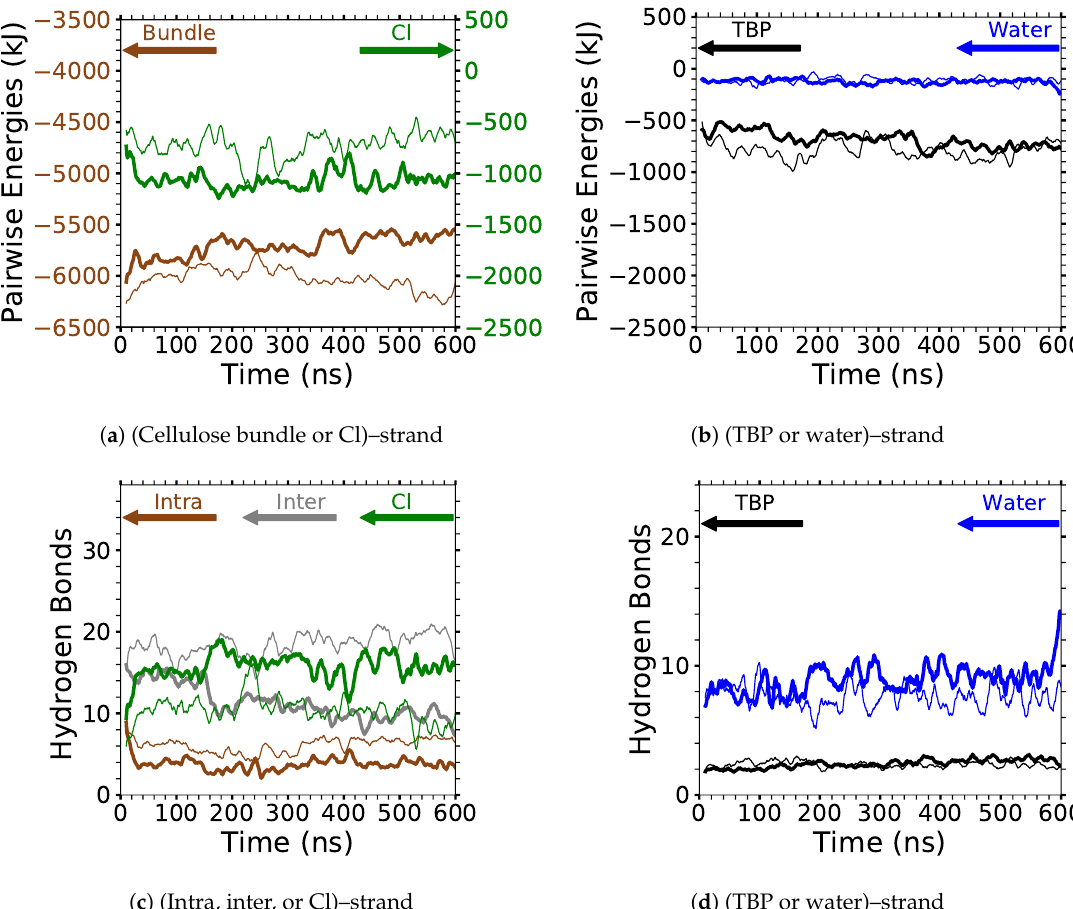
Figure A16. Pairwise energies and hydrogen bonding of the peeling strand(s) at 86.8mol%water and 360K. The pairwise energies of the separating strand(s) between the: ( a ) (cellulose bundle or Cl)–separating strand; ( b ) (TBP or water)–separating strand. The number of hydrogen bonds for the separating strand(s) per the given type: ( c ) (intra, inter, or Cl)–separating strand; ( d ) (TBP or water)–separating strand. The thick line is the first yellow strand to peel, and the thin line is the non-peeling yellow strand or second strand to peel. If neither of the stands peel, then both the thick and thin lines are non-peeling yellow strands. The data were averaged over 1000 data points, using a rolling